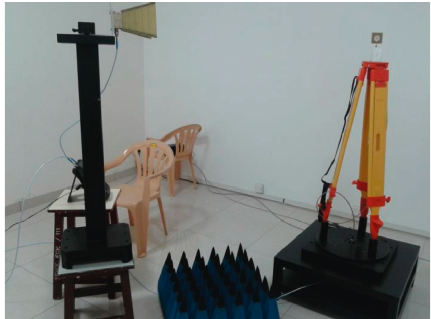
Figure 4: Radiation pattern measurement setup.